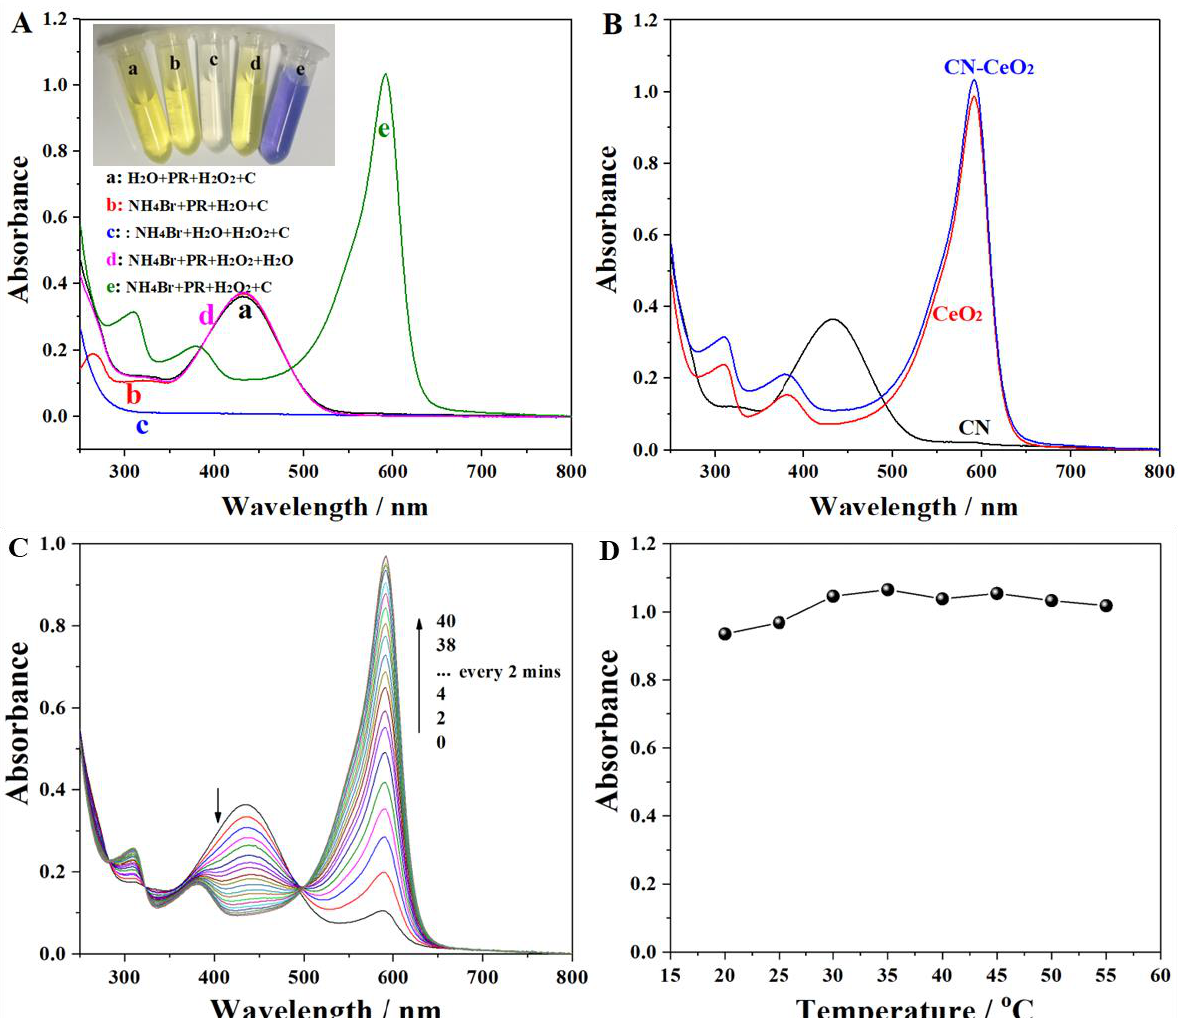
Figure 2. ( A ) Absorbance spectra in different reaction systems: (a) H 2 O + PR + H 2 O 2 + C, (b) NH 4 Br + PR + H 2 O + C, (c) NH 4 Br + H 2 O + H 2 O 2 + C, (d) NH 4 Br + PR + H 2 O 2 + H 2 O, and (e) NH 4 Br + PR + H 2 O 2 + C. C: N-C/CeO 2 . ( B ) Absorbance spectra of solutions catalyzed by N-C composites, CeO 2 ,